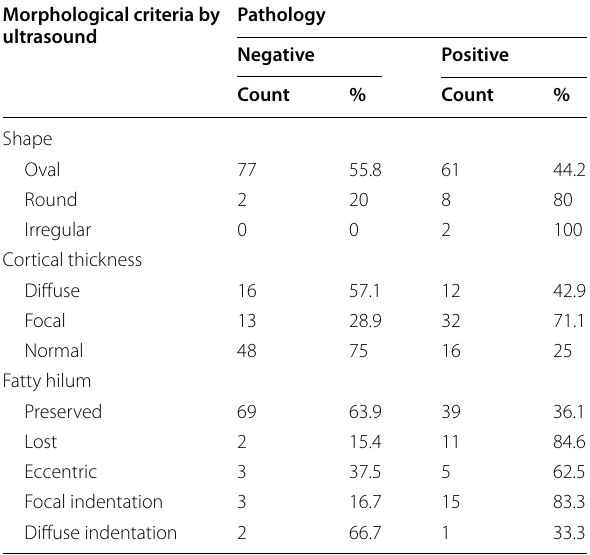
Table 2 Correlation between the morphological criteria of the lymph node by US and final pathology